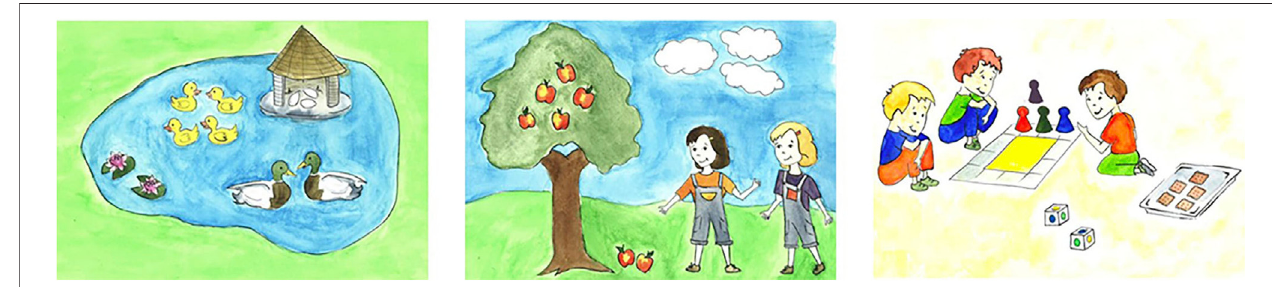
FIGURE 1 | The pictures used in the verbally-based SFON task, drawn by Luisa